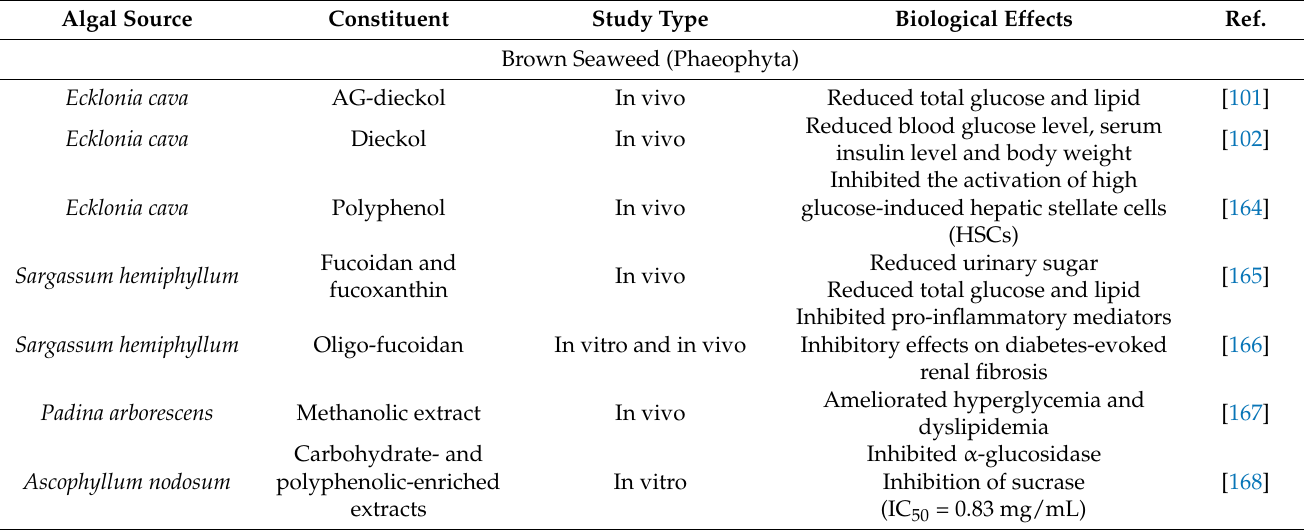
Table 4. The effects of seaweed-derived compounds on